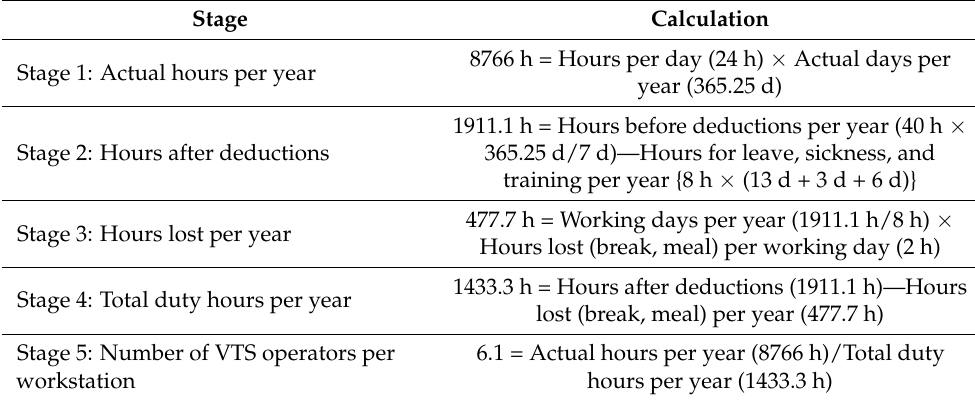
Table 5. Calculation for the number of VTS operators per